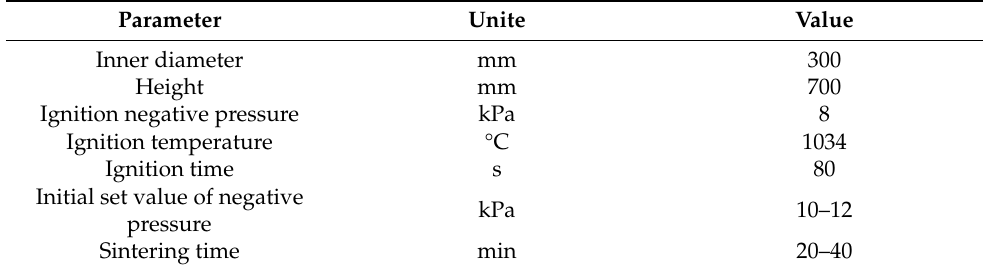
Figure 1. The schematic diagram of the sintering pot test system. Table 3. The parameters of the sintering